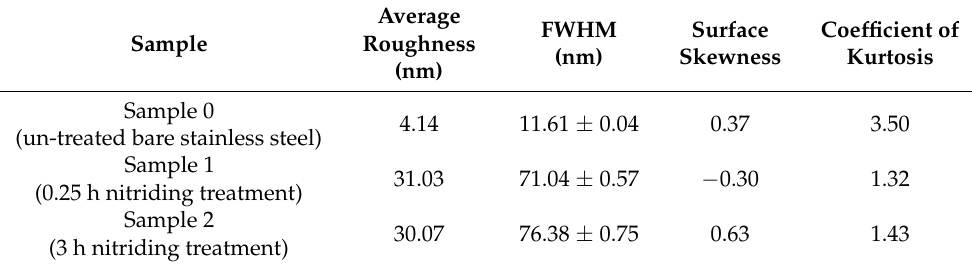
Table 1. The roughness parameters of un-nitrided and nitrided AISI 304 SS. Sample